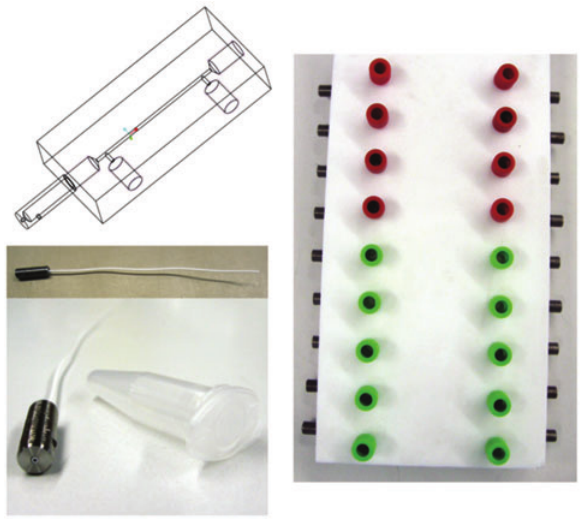
Figure 4 Model of one channel and one ferrule for potting and sealing the hollow fiber on both ends (left). Membrane module with nine single channels